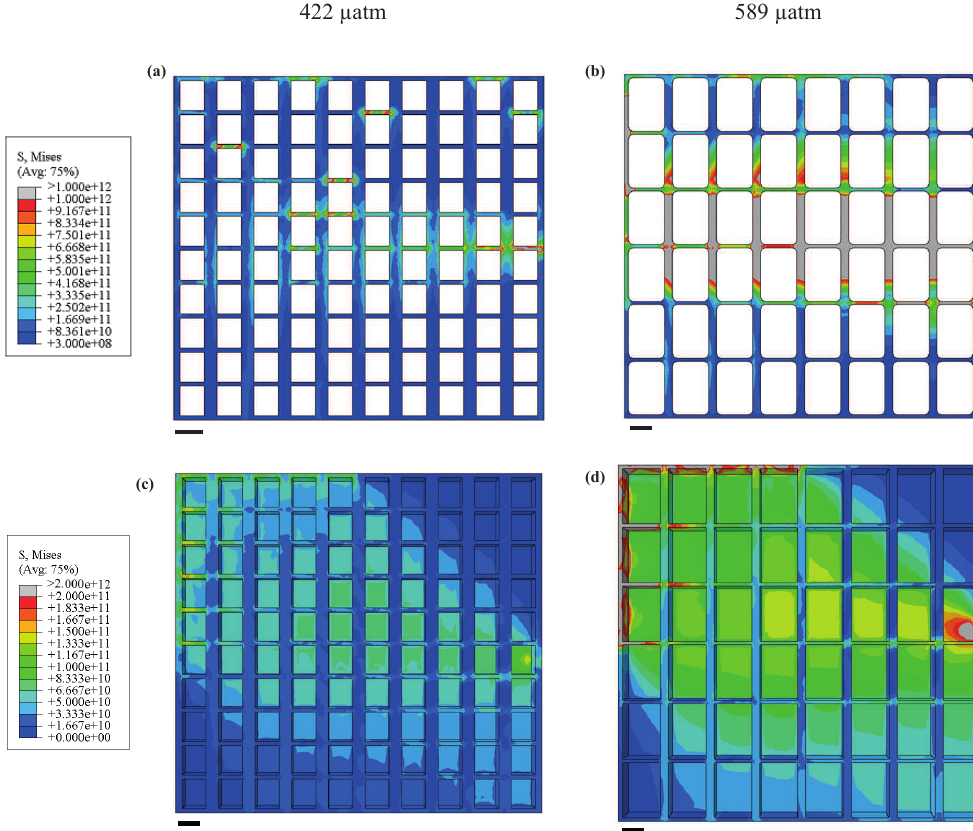
Figure 2. The effect of elevated CO 2 on the Lithothamnion glaciale structure. All models are subjected to the same loads and boundary conditions and measurements taken from Ragazzola et al. (2012). Von Mises stresses are projected onto the 2-D Finite element model (a, b) and the 3-D compartmentalised models (c, d) . Warm colours indicate areas of high stress, while cooler blue colours indicate areas of low stress. Units =